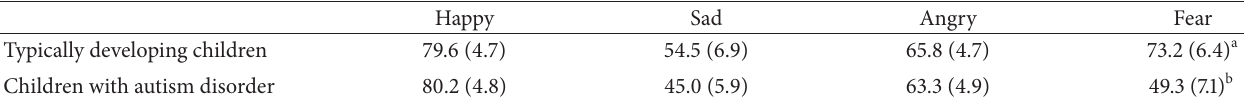
Adjusted group means as percent correct values are shown. Group means are adjusted for VMA. Standard deviations are in parentheses. a,b Superscripts indicate significant between-group differences, 𝑃 ≤ .05